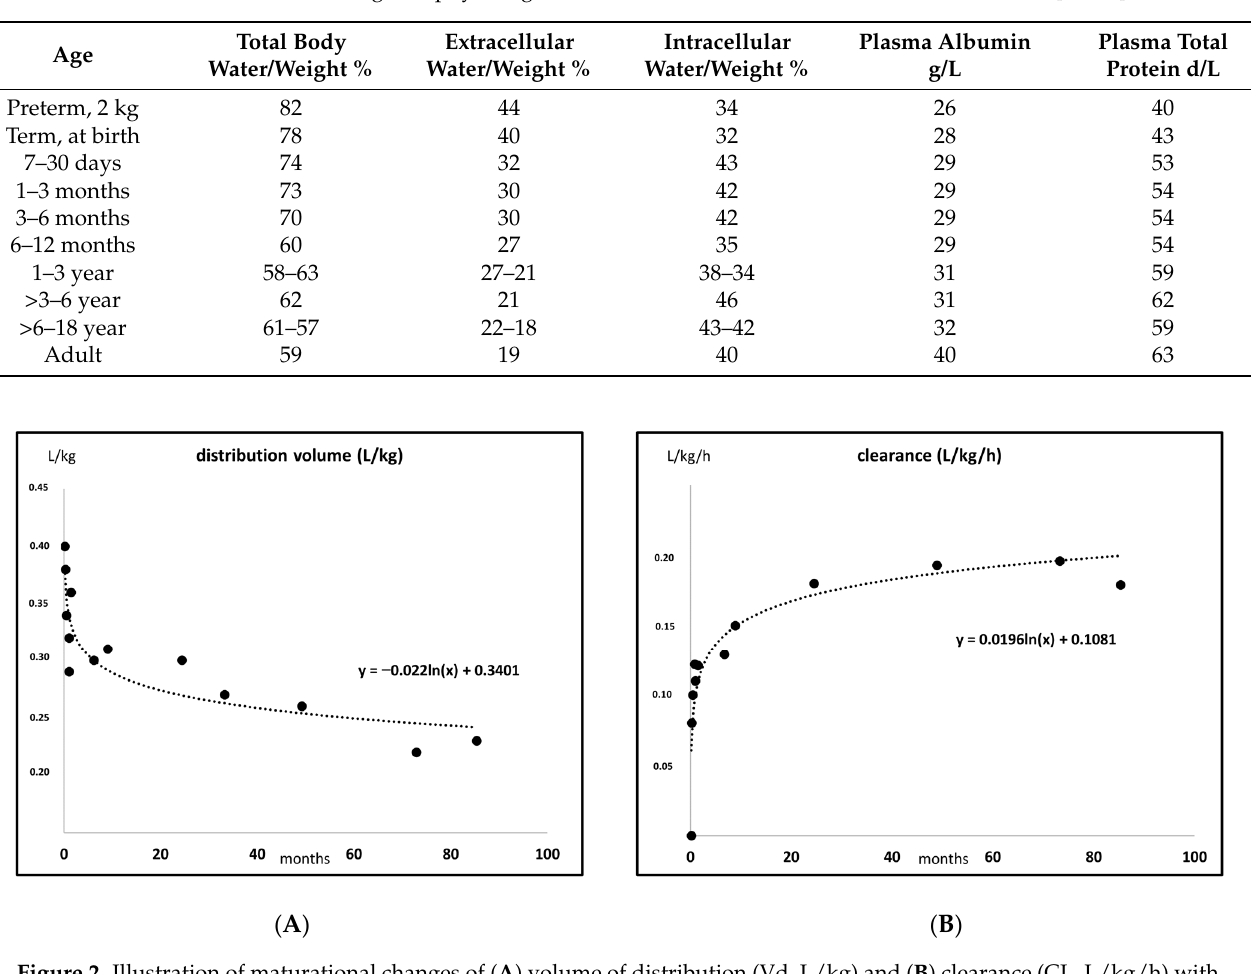
Table 1. Maturational changes in physiologic variables relevant to the distribution of antibiotics [25–27].